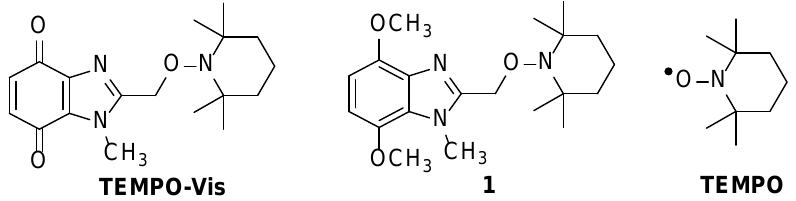
Figure 1. TEMPO-Vis , synthetic precursor 1 , and TEMPO free radical.